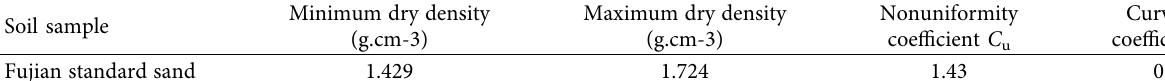
Table 2: Basic physical parameters of standard sand.